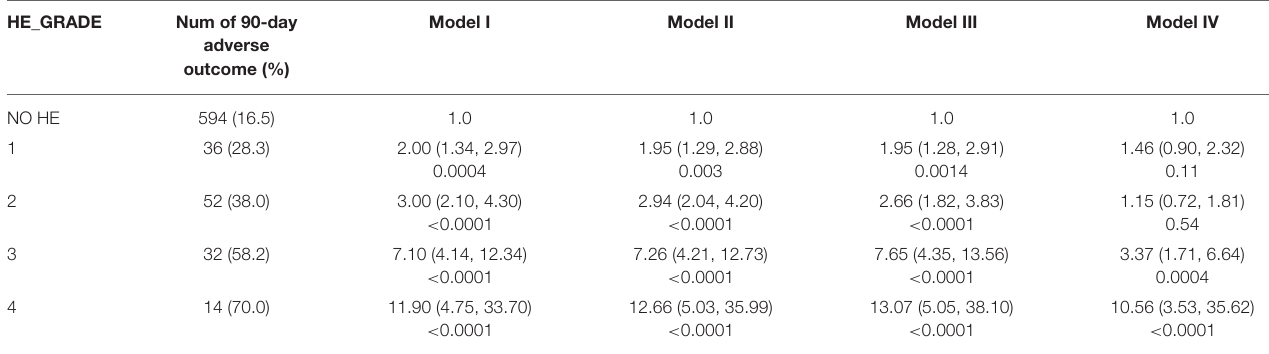
TABLE 5 | Odds ratios and p -values of HE grades in the total population at day 90.